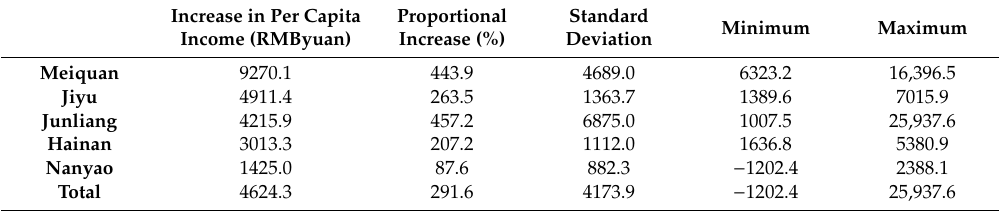
Table 3. Changes in per capita income in the surveyed villages in Lashi Township from 2005 to 2015.